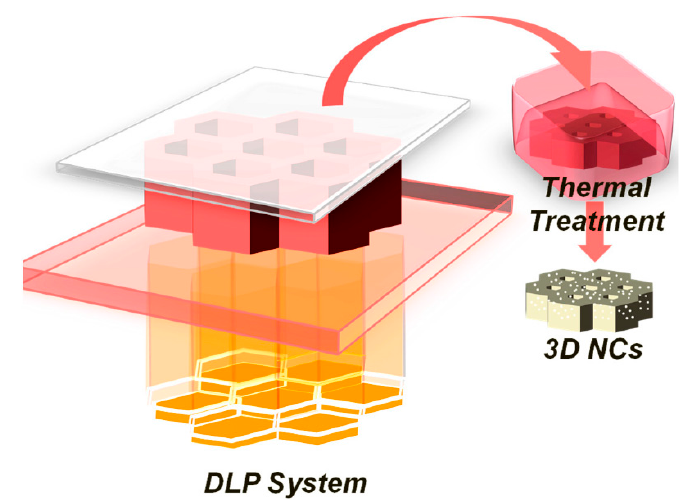
Figure 8. Sketch of Digital Light Processing (DLP) setup that projects dynamic digital masks on the photocurable formulation featuring the formation of the polyethylene glycol diacrylate structure. Subsequent thermal treatment, with the formation of the silver nanoparticles by reduction of the metal precursors. Reprinted from [37], © 2016, with permission from MDPI AG.